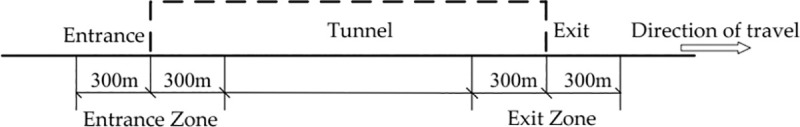
Zone divisions at tunnel entrance and exit.